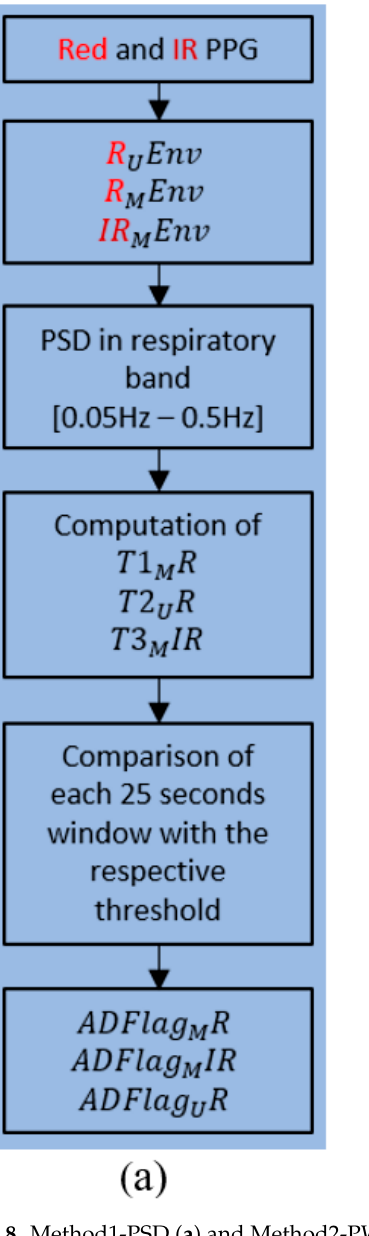
Figure 8. Method1-PSD ( a ) and Method2-PWA ( b ) detailed schemes. PWA: Pulse Wave Amplitude.